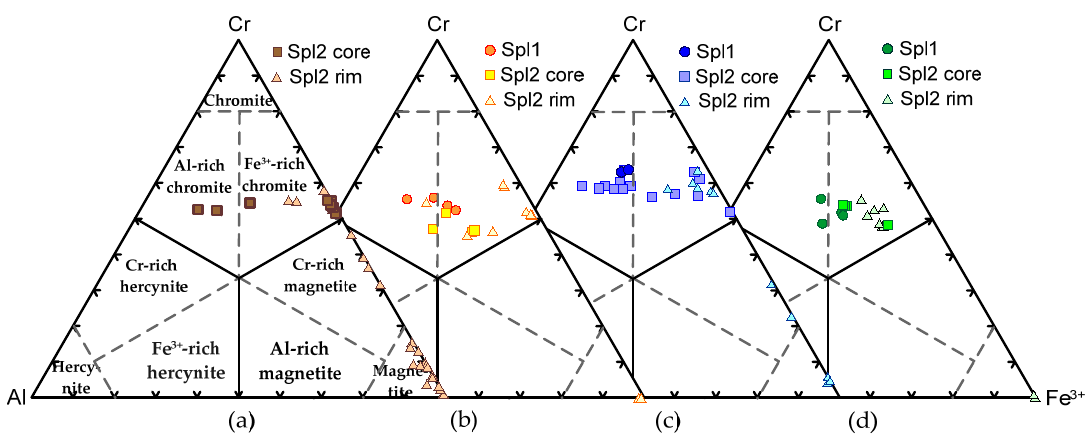
Figure 6. Compositional variations of Cr-spinels from ultramafic rocks of the Primorsky Ridge in terms of the Al-Cr-Fe 3 + diagram. ( a ) The Moriany intrusion; ( b ) The Ulan-Khan intrusion; ( c ) The Zunduk intrusion; ( d ) The Ongureny intrusion. The diagrams are split to avoid overcrowding. The fields of spinel composition are from [34]. Sp1: Type I Cr-spinel; Sp2: Type II Cr-spinel.